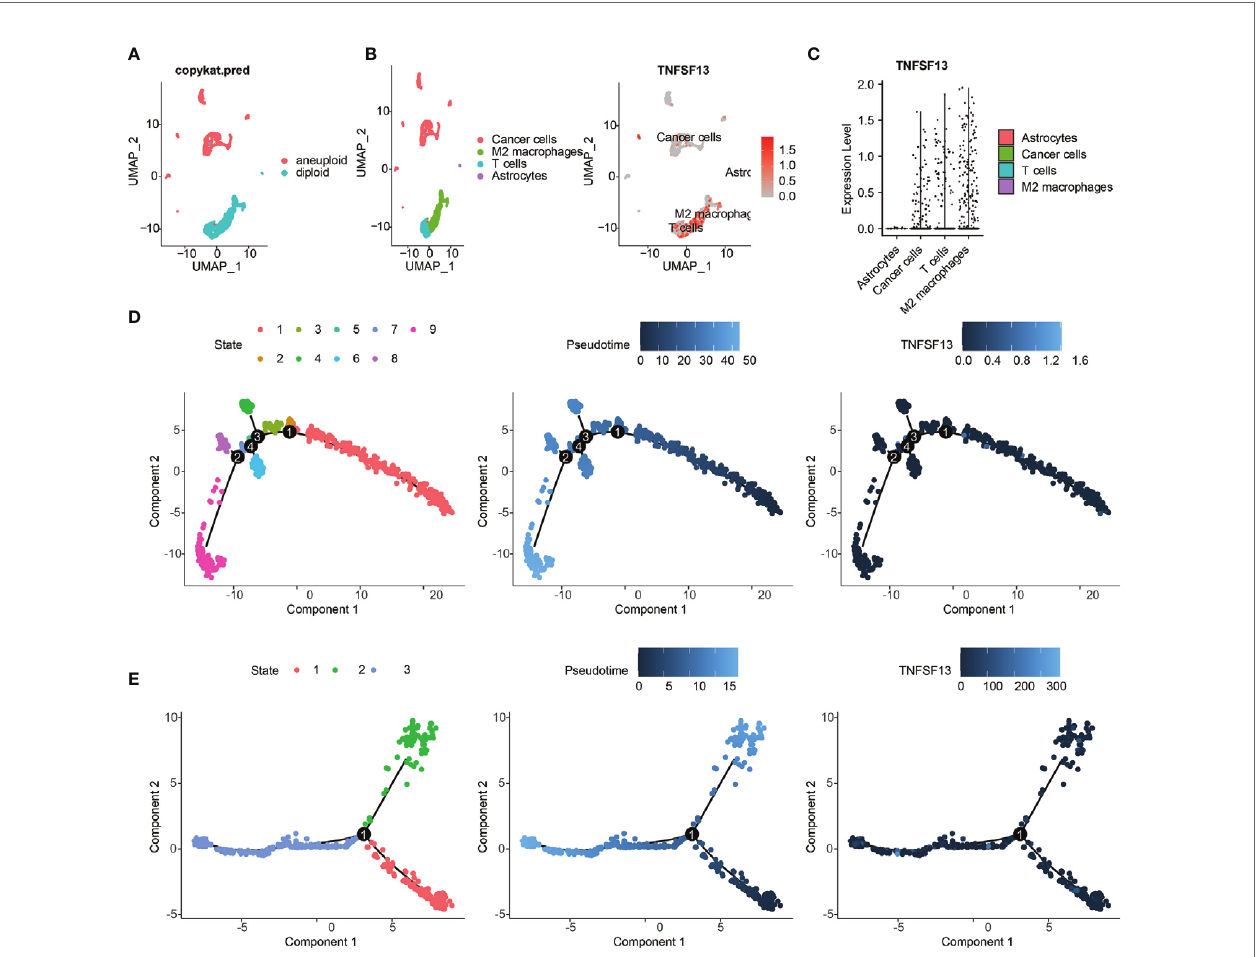
FIGURE 5 | scRNA-seq results for TNFSF13 in GBM. (A) Tumor cells were de fi ned as cells with aneuploid using R package copykat. (B) ( Left ) Cells were annotated into fi ve clusters. ( Right ) Scatter plots of TNFSF13 expression in fi ve clusters. Gray dots represent cells without TNFSF13. Red dots represent cell with TNFSF13 expression, and the shade of red represents expression level. (C) Violin plot of TNFSF13 expression distribution of fi ve cell clusters. (D) Single-cell trajectory analysis of neoplastic cells reveals four main branches. Cells are colored based on states ( left ), pseudotime ( middle ), and TNFSF13 expression ( right ). (E) Single-cell trajectory analysis of macrophages reveals four branches. Cells are colored based on states ( left ), pseudotime ( middle ), and TNFSF13 expression ( right